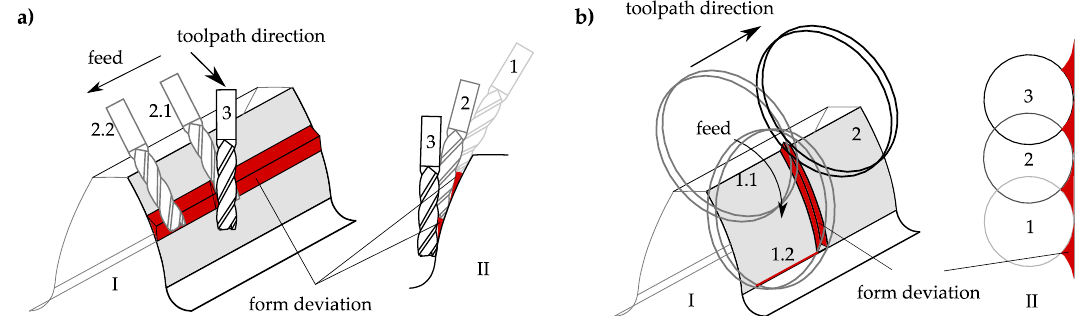
Figure 1. Comparison of the milling strategies standard freeform-milling ( a ) and InvoMilling™ ( b ) [8], Copyright © Thomas Glaser 2018.